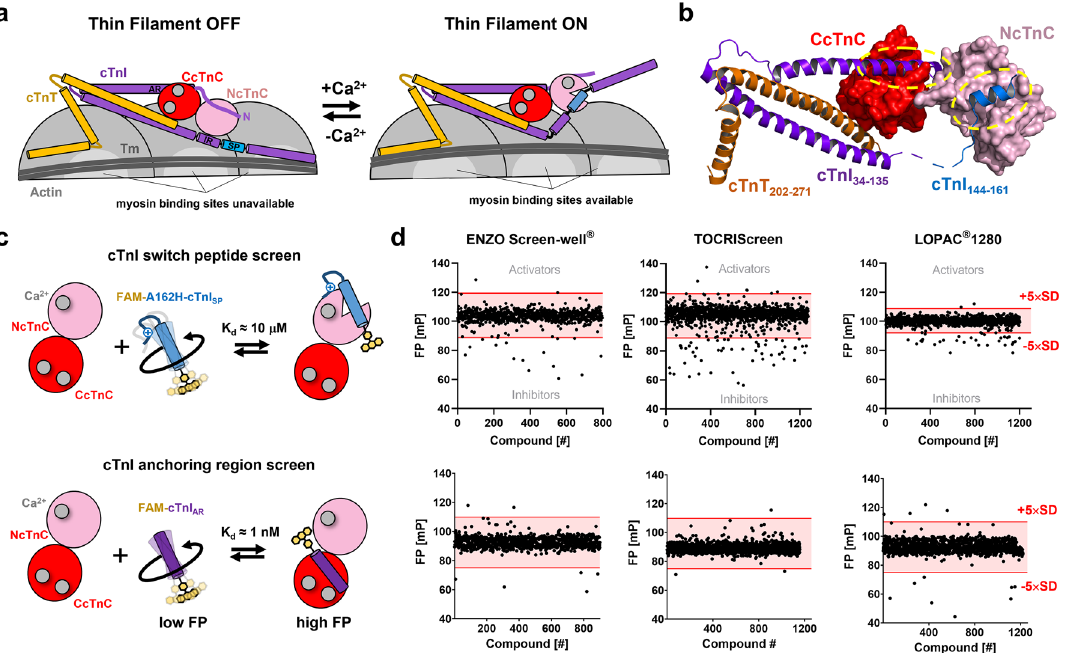
Figure 1. High throughput screens for cardiac troponin modulators. ( a ) Schematic illustration of the calcium- dependent thin filament activation pathway. In the thin filament OFF state (left), myosin binding sites on actin (light gray) are blocked by tropomyosin (Tm; dark gray). Ca 2+ binding to troponin C (cTnC; red) allows switch peptide (SP; blue) interaction with the regulatory N-lobe of cTnC (NcTnC; pink). Removal of the C-terminal domain of cTnI (CTD) allows Tm to move azimuthally around the thin filament, exposing myosin binding sites on actin. The C-lobe cTnC (CCTnC; red) is constitutively bound to divalent cations and the anchoring region of cTnI (purple). ( b ) Atomic structure of the human cardiac troponin core complex (PDB 1J1D). The N- and C-lobe of cTnC are shown in surface representation in red and pink, respectively. Cardiac troponin I (cTnI) and troponin T (cTnT) are shown in purple and orange, respectively. The switch region of cTnI is shown in blue. Molecular interactions between cTnC and cTnI are highlighted by yellow dashed ovals. ( c ) Cartoon representation of the developed fluorescence polarization (FP)-based HTS that target cTnC-cTnI interactions. Top: FP-based screen targeting the interaction between NcTnC and the switch region of cTnI. Bottom: FP-based screen targeting the interaction between CcTnC and the anchoring region of cTnI. ( d ) HTS of three commercially available compound libraries targeting the interaction between cTnC and switch peptide (top) or the anchoring region of cTnI (bottom). Hits were defined by compounds that change the FP more than five times the standard deviation (5xSD) away from the average value (indicated by red